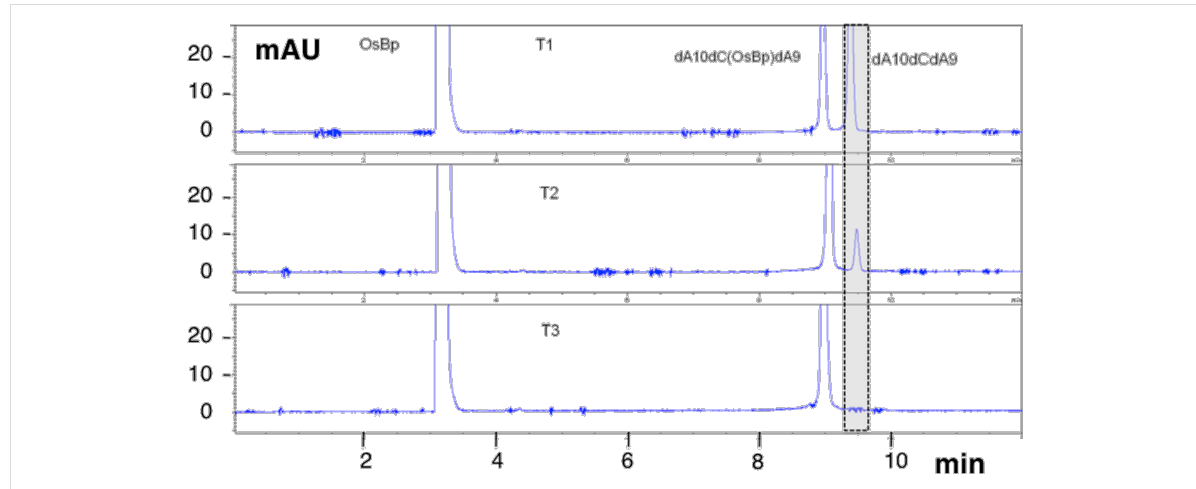
Figure 2: Reaction of 12.6 mM OsBp (the highest concentration of OsBp used under our conditions) with 20 μ M dA 10 dCdA 9 monitored automatically by CE (see Experimental section, Part A). Reactants were mixed in a CE vial and aliquoted/analyzed automatically by the instrument. T1 represents 6 min, T2 24 min and T3 76 min incubation after mixing. Signal is shown at 260 nm. Reaction mixture was incubated at 25 ± 1 °C within the ther- mostated autosampler of the instrument. Shaded peak is the original oligo that migrates last, OsBp is neutral and migrates early. The reaction prod- uct (osmylated oligo) migrates ahead of the intact oligo. Oligo dA 10 dCdA 9 used in this reaction was PAGE-purified with confirmed purity by CE at 97%. The small spikes, at about 1 mAU with no steady migration time, are due to noise; the peak height of both oligo and osmylated oligo reach 120 mAU.